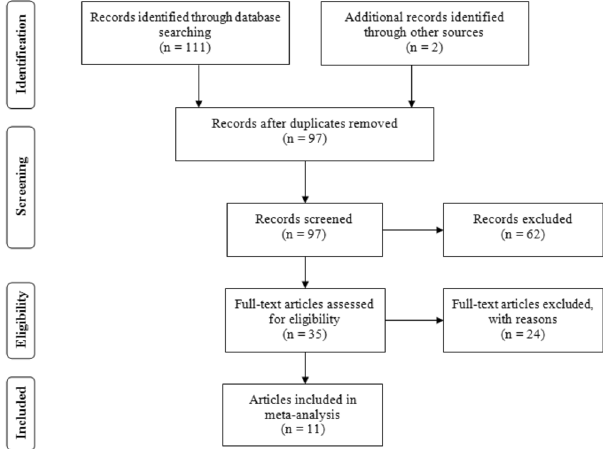
Figure 1. The flow diagram of the included and excluded